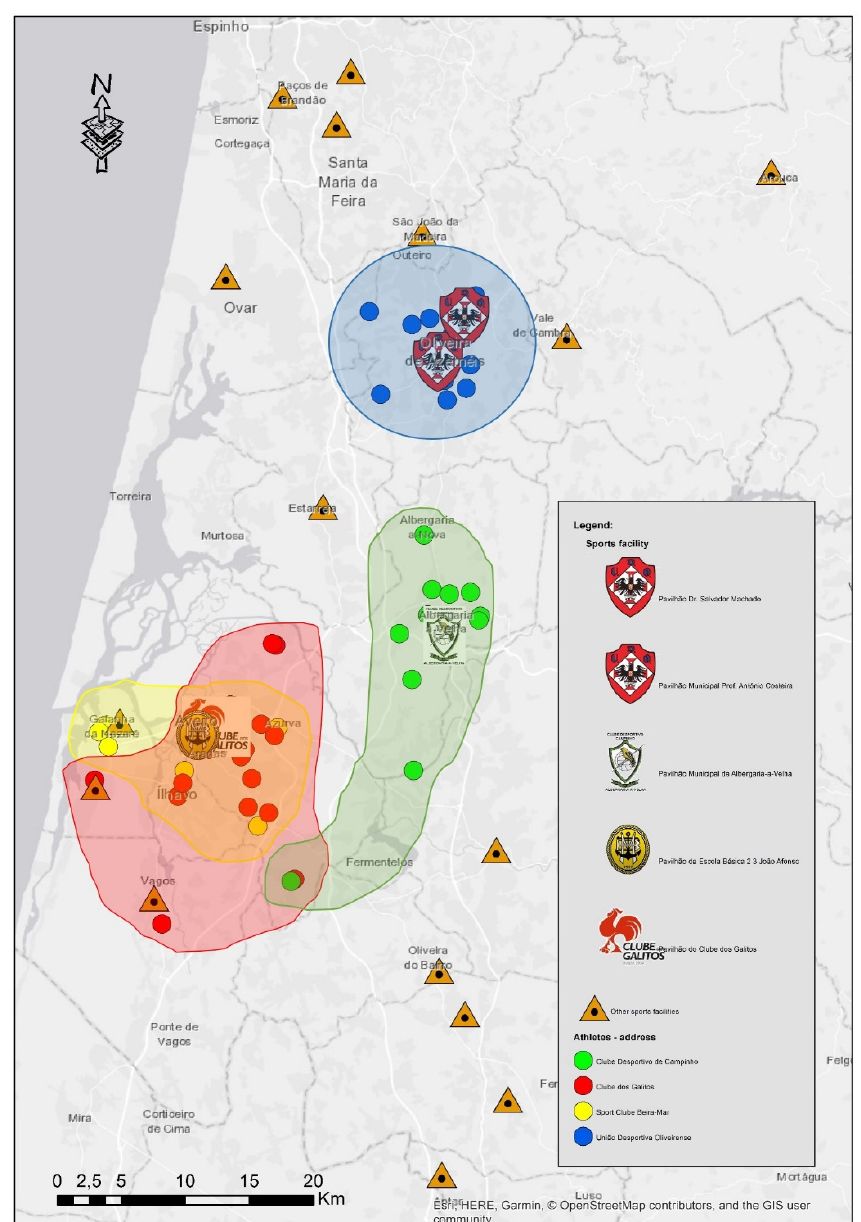
Figure 2. Identification of the catchment areas of the 4 clubs under study .